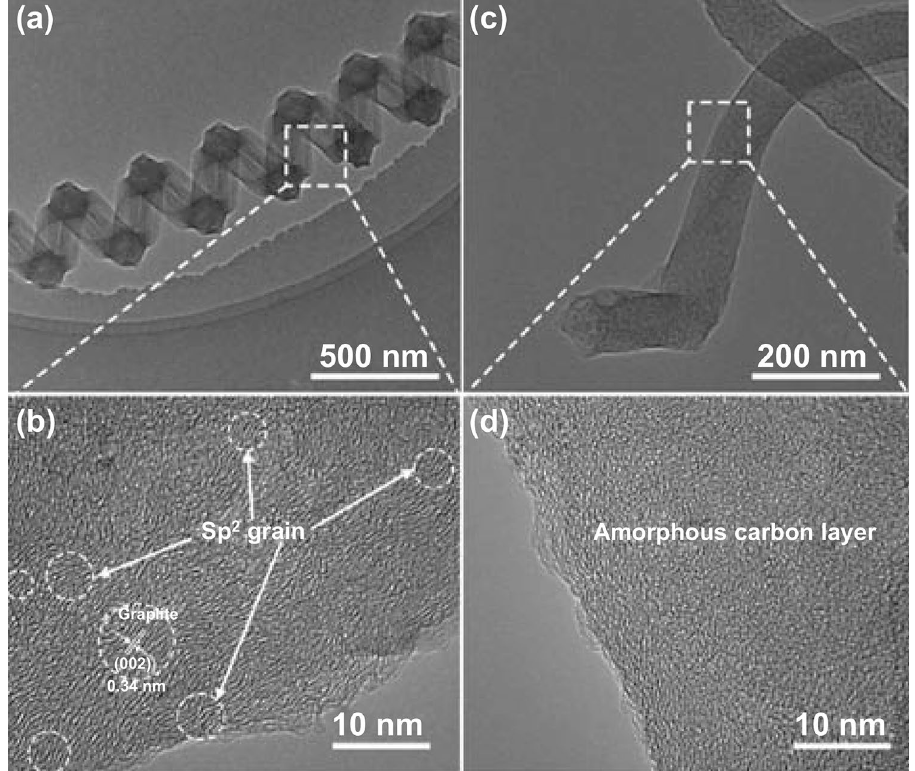
Fig. 2 TEM and HRTEM images of a single CNC ( a, b ) and a single CNF ( c,